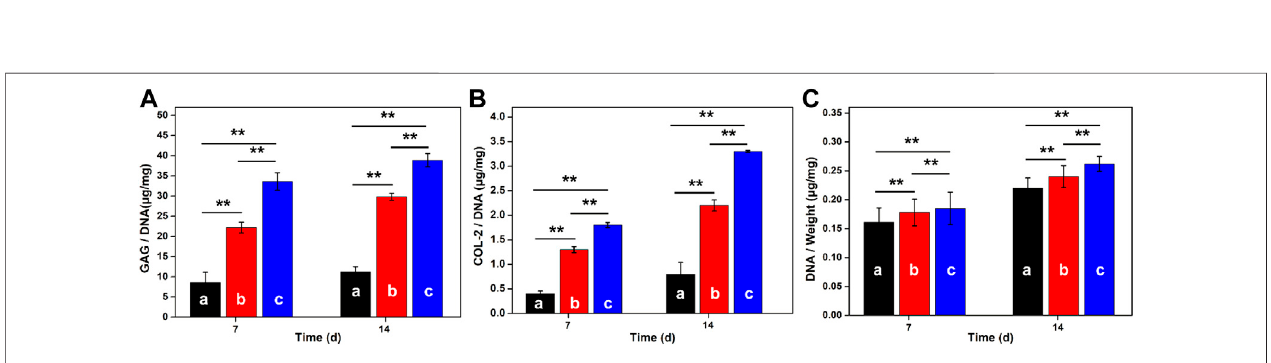
FIGURE6| GAGproduction, COL-2proteinsand DNAcontentsinhydrogelsafter culturing for7and14 days (A) GAGproduction, (B) COL-2deposition,and (C) DNA contents in various hydrogels scaffolds of (A) GelMA, (B) GelMA-CS, and (C) GelMA-CS@KGN by the BMSCs on 7 and 14 days ( n = 3, ** p < 0.01).